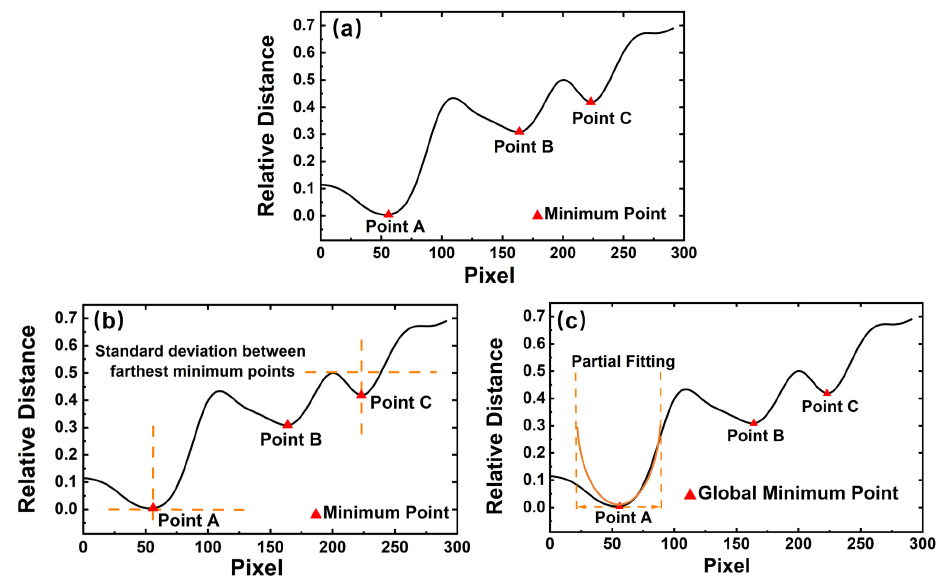
Figure 4. Three features of the image without a mask: ( a ) number of minimum points of the contour curve; ( b ) standard deviation between the farthest minimum points of the contour curve; and ( c ) quadratic coefficient of the partial fitting curve.